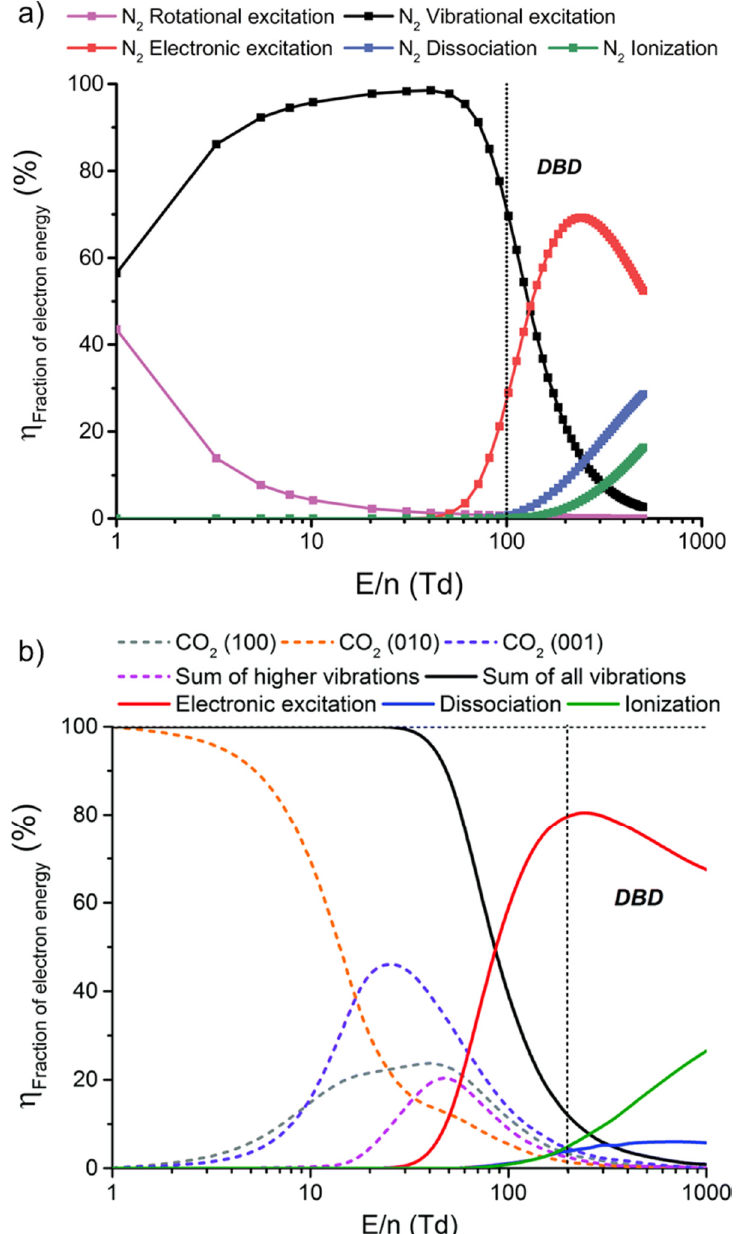
Figure 2. Electron energy loss channels in ( a ) N 2 plasmas and ( b ) CO 2 plasmas as a function of the reduced electric field. The vertical dashed line indicates the start of the DBD regime (Reproduced with permission from [66]. Copyright 2020, ACS).